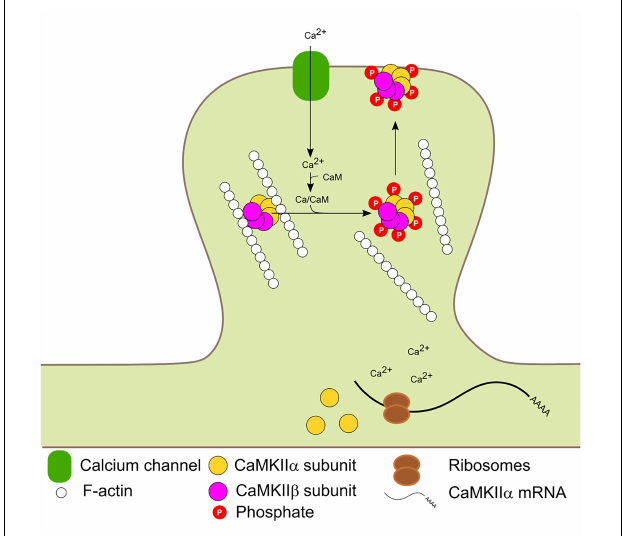
FIGURE 3 | Activity dependent PSD translocation and CaMKII α dendritic translation. Synaptic activity leads to Ca 2 + influx. Subsequent Ca 2 + /CaM binding to CaMKII α and β induce F-actin dissociation, translocation to the PSD and autophosphorylation at T286 and T287 in α and β isoforms, respectively. Calcium entry also enhances local CaMKII α mRNA